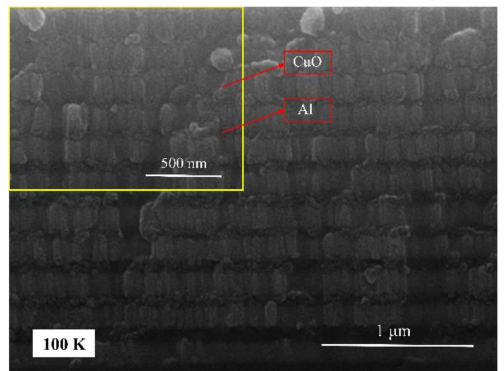
Figure 1. SEM cross-sectional view of nano Al/CuO composite